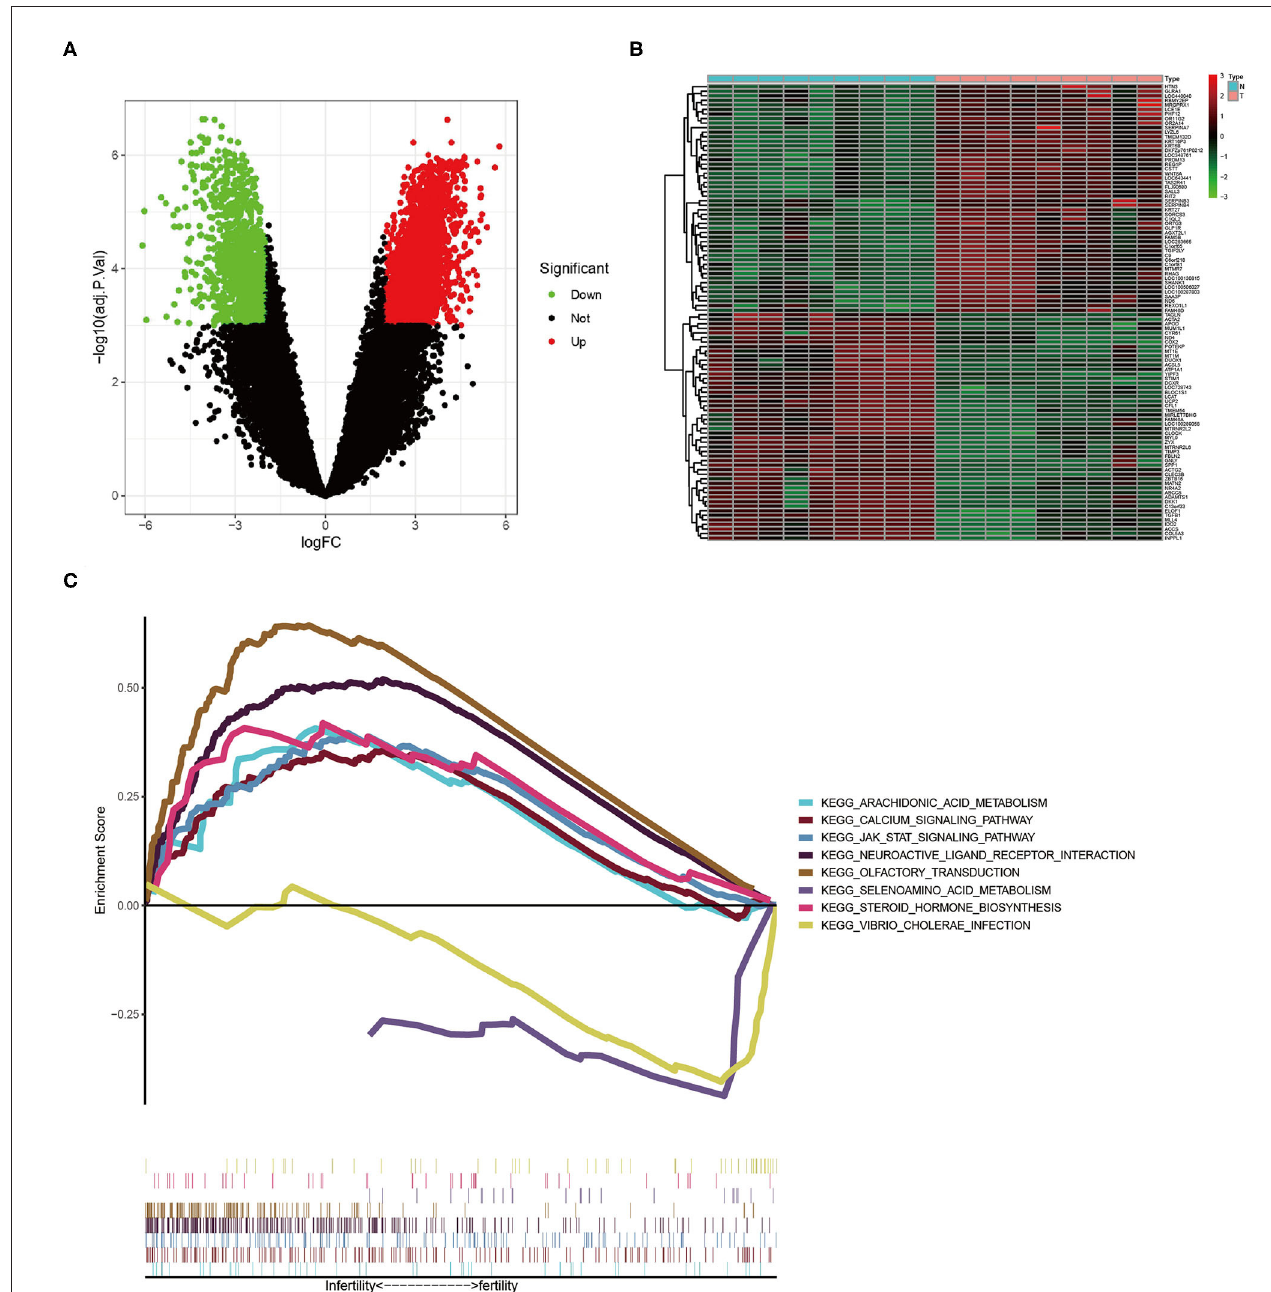
FIGURE 1 | (A) The volcano plot of DEGs. (B) The heat map of DEGs (only the 50 most up-regulated and down-regulated genes are shown, respectively). (C) The results of GSEA enrichment analysis. hydroxylase activity, heme binding, oxygen binding. The results of KEGG enrichment analysis found that the cause of infertility in endometriosis may be related to the metabolism of a variety of amino acids (tyrosine, phenylalanine, tryptophan, arginine, proline, etc.), Ras signaling pathway, cAMP signaling pathway, Ovarian steroidogenesis, and so on ( Figure 3F , Supplementary Table 10